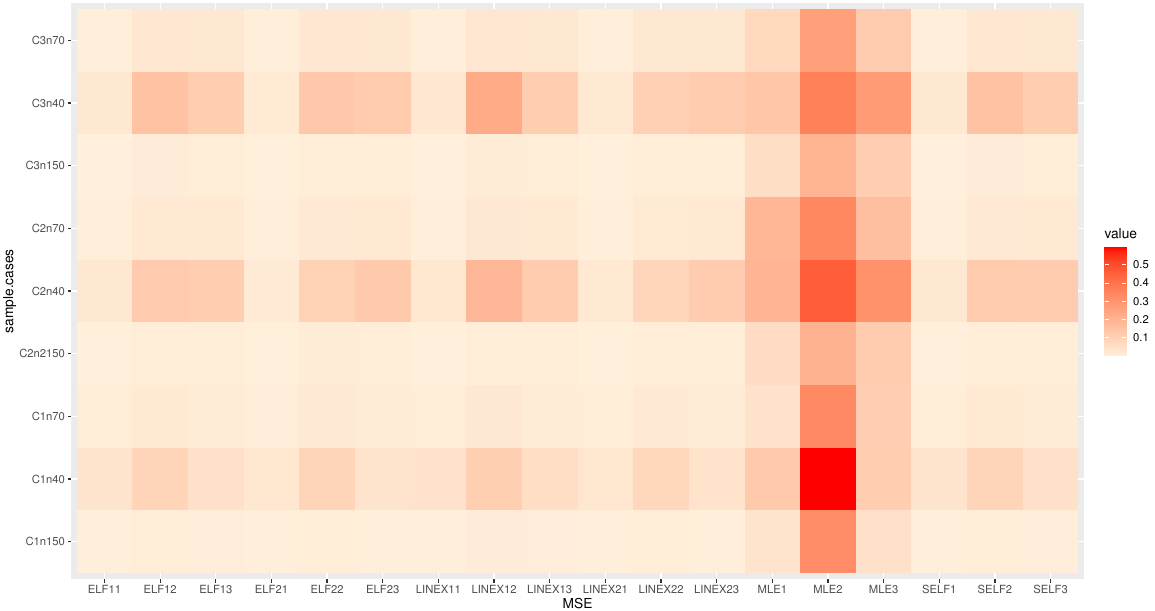
Figure 7. Heatmaps of MSE values for parameters of the KMWE distribution with different sample cases: α = 0.5, β =